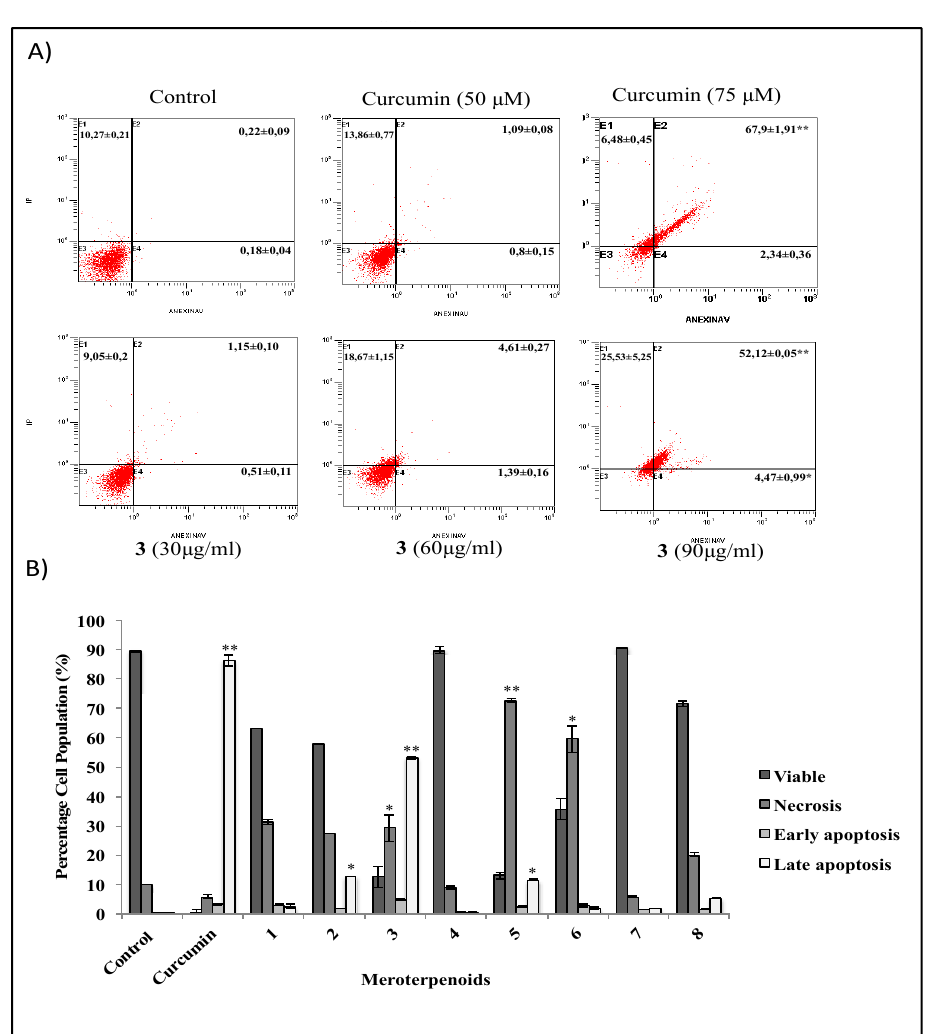
Figure 3. Apoptosis rates by flow cytometry of HT-29 colon cancer cells treated with the meroterpenes (AMTs) 1 - 8 for 24 h. Negative control cells received no treatment. Positive control received 50 and 75 μ M of curcumin. ( A ) Representative flow cytometry histograms showing the percentage of HT-29 cells undergoing early and late apoptosis after treatment with 30, 60, and 90 μ g/mL of AMT 3 . The abbreviations are necrosis (E1), early apoptosis (E2), viable (E3), and late apoptosis (E4). ( B ) Bar charts illustrate the percentage of viable, necrotic, early, and late apoptosis cells treated for 24 h with 28 μ g/mL of curcumin (positive control), 30 μ g/mL of 1 , 2 , 5 , 6 , 7 , and 8 , and 90 μ g/mL of 3 and 4 . Data represent mean ± SE from three independent experiments. Significant differences from control group: * p < 0.05 and ** p <